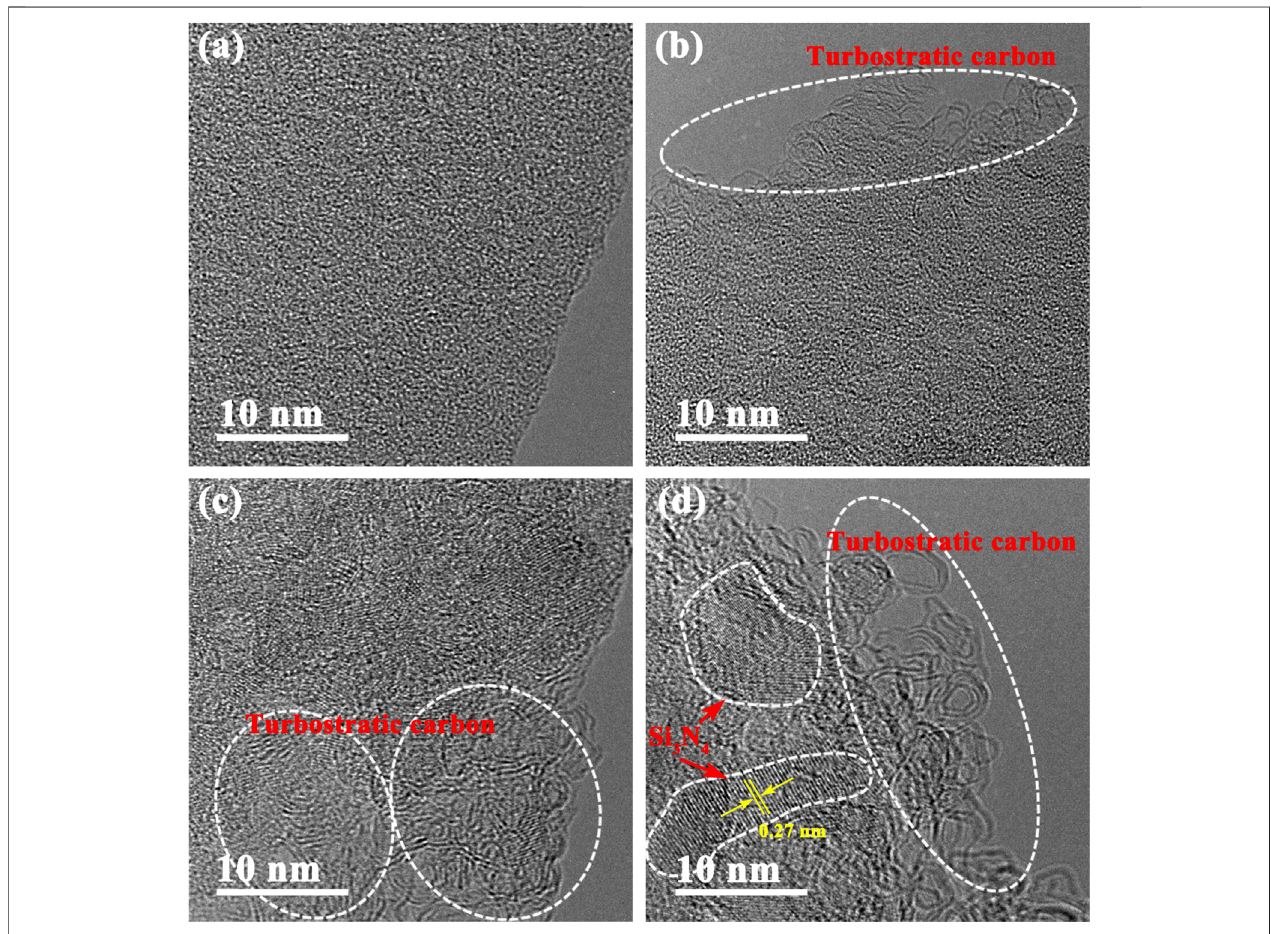
FIGURE 3 | TEM micrographs of SiCN fi bers after annealing at different temperatures: SCN-1,300 (A) , SCN-1,400 (B) , SCN-1,500 (C) , and SCN-1,600 (D) .